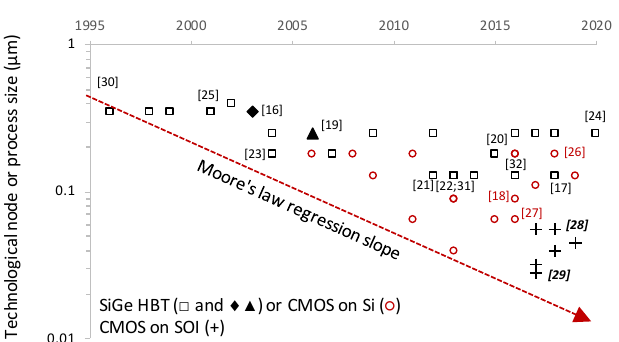
Figure 5. MMIC VCOs technological trends: the technological node used is plot versus the year of publication. BiCMOS HBT-based VCOs ( □ and also authors’ personal work ♦▲ ) and CMOS-based VCOs on Si ( ◦ ) and SOI ( + ). The regression line illustrates Moore’s law. Some references used in the